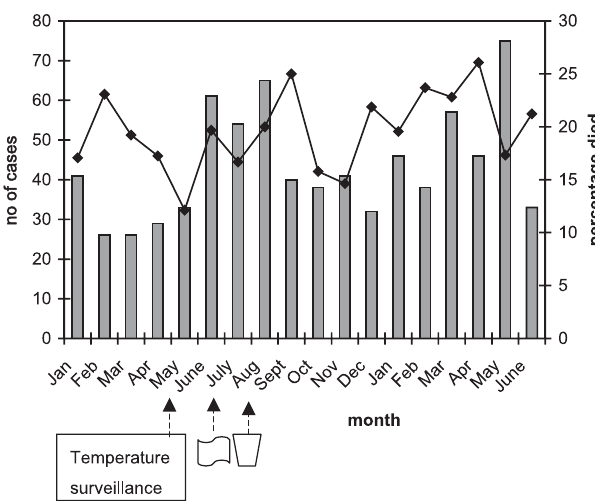
Figure 4. Monthly Admission of Children with Severe Malnutrition (Bars) and Percentage Case Fatality (Line) for 2001–2002 In July 2001, during a period of 6-h temperature surveillance, the routine prescription of a blanket (see blanket symbol) was added to the treatment chart, and in August 2001 (see cup symbol), F75 and F100 were prepared (day and night) in a specifically devoted ‘‘ milk kitchen ’’ with dedicated trained workers to expressly supply the malnourished with warm milk feeds every 4 h, or as